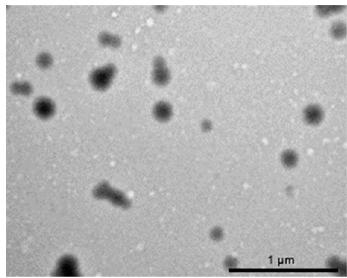
Figure 3. TEM images of acetazolamide-loaded HEMA/Bayfit-MA copolymer NP5